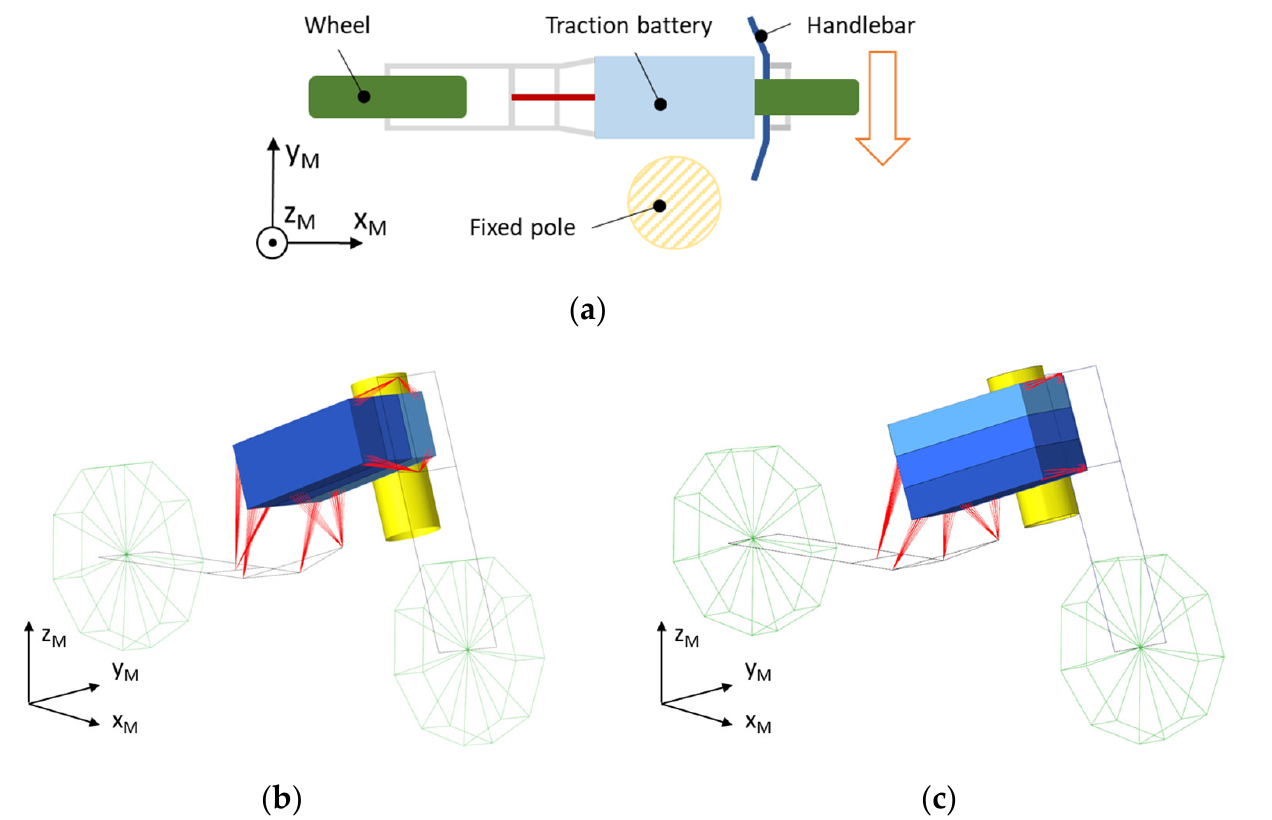
Figure 2. Schematic top view representation of the collision con fi guration ( a ) and simpli fi ed FE E-PTW model with traction ba tt ery: ( b ) Concepts Y and ( c ) Concept Z.